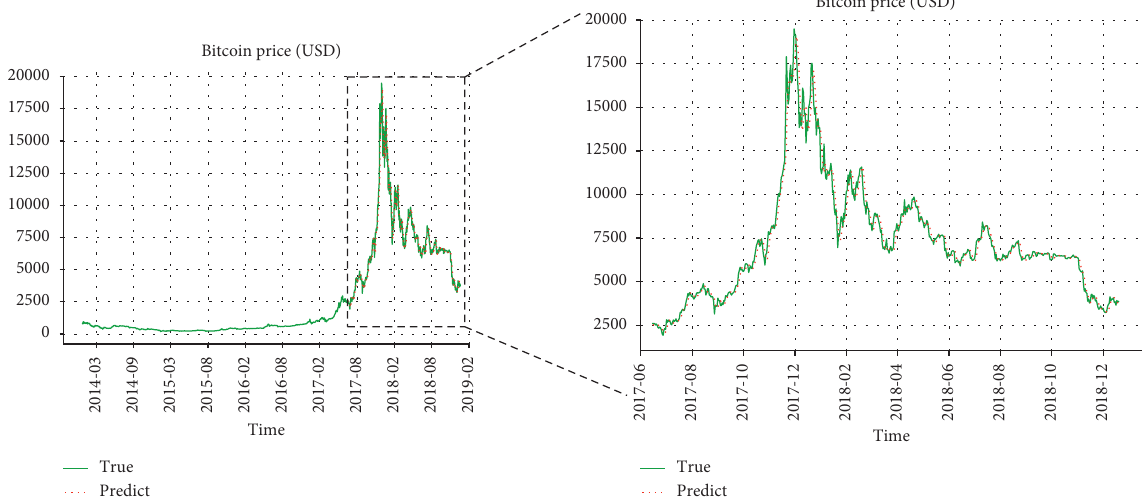
Figure 2: The bitcoin price prediction without consideration of the S&P index.